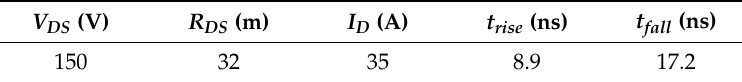
Table 6. Technical specifications of IRFB5615PBF MOSFET.